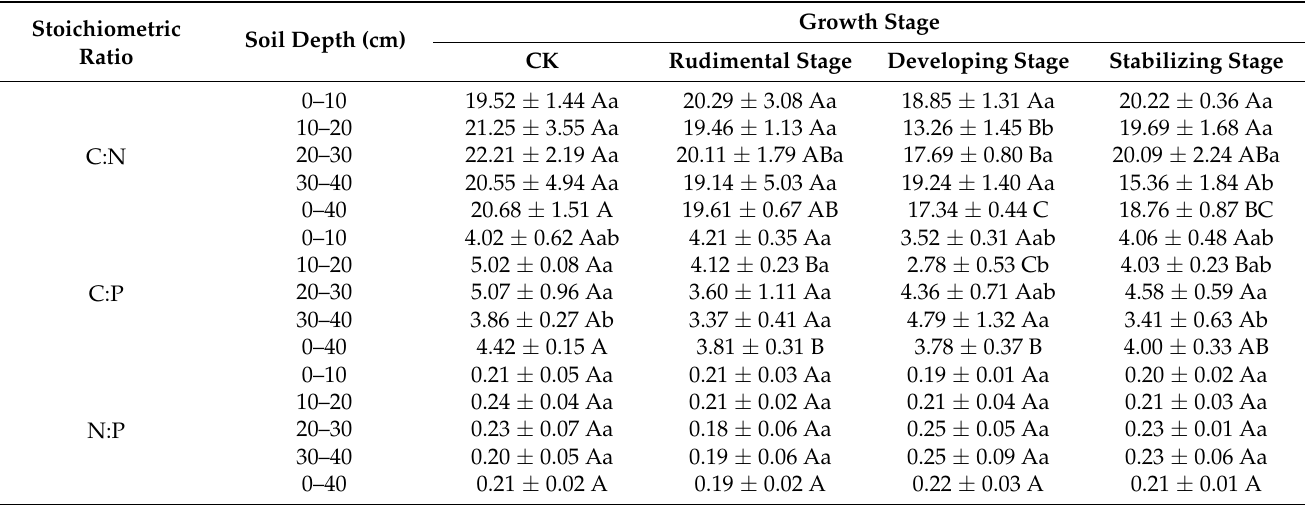
Table 3. Stoichiometric ratio of soil organic carbon, total nitrogen, and total phosphorus at different growth